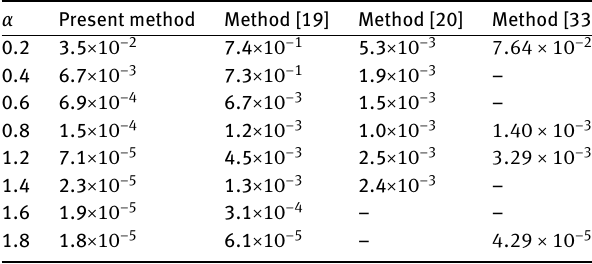
Table 2: Comparison of maximum absolute errors in [0, 1] for Exam- ple 1.